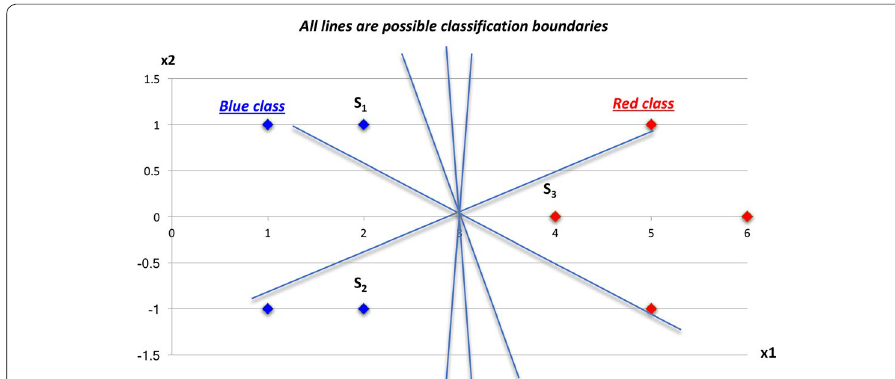
Fig. 1 SVM options for decision surface discovery